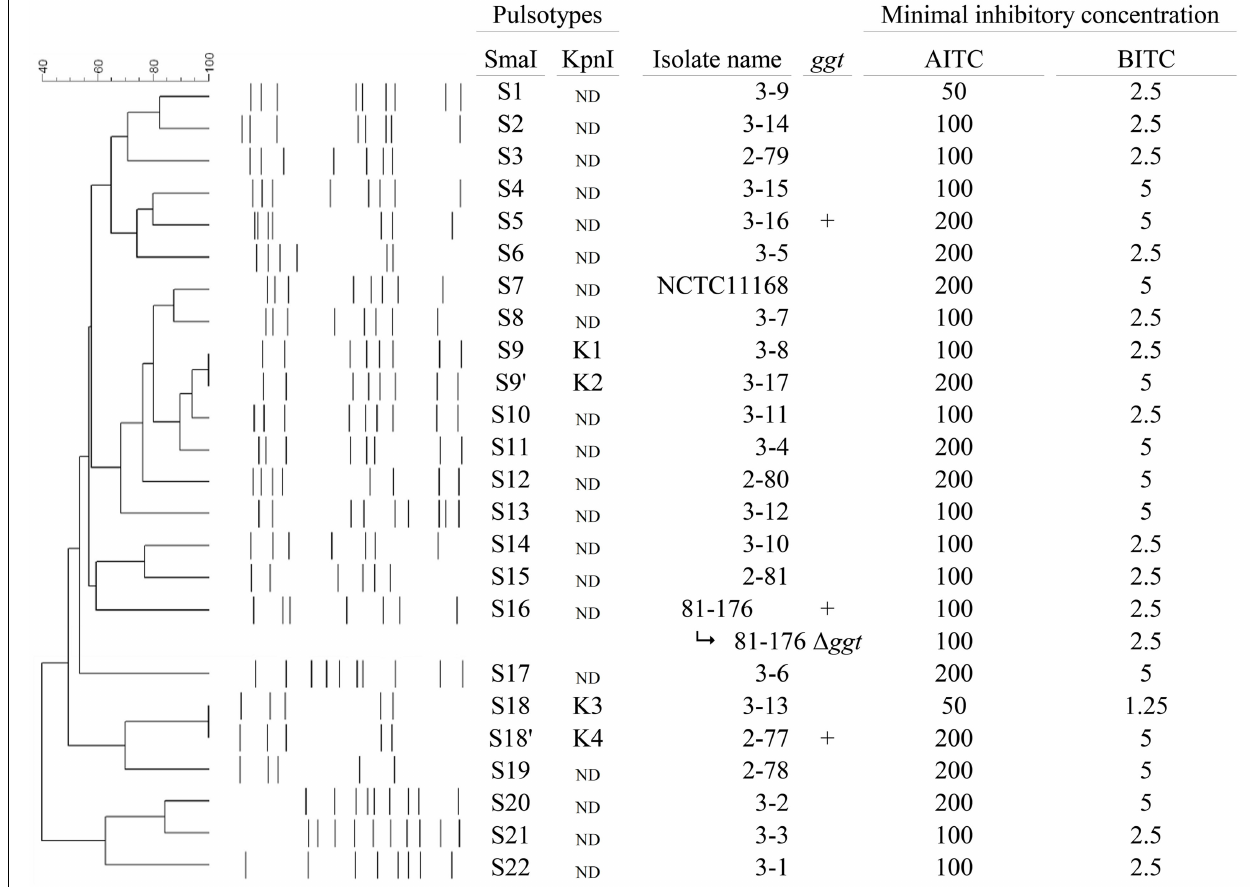
24 isolates; ggt: + : positive PCR amplification of ggt gene with both primer pairs; MIC of AITC and BITC, expressed as the lowest concentration ( μ g mL − 1 ) inhibiting all visible growth of a 5 × 10 5 -CFUmL − 1 inoculate. ND: